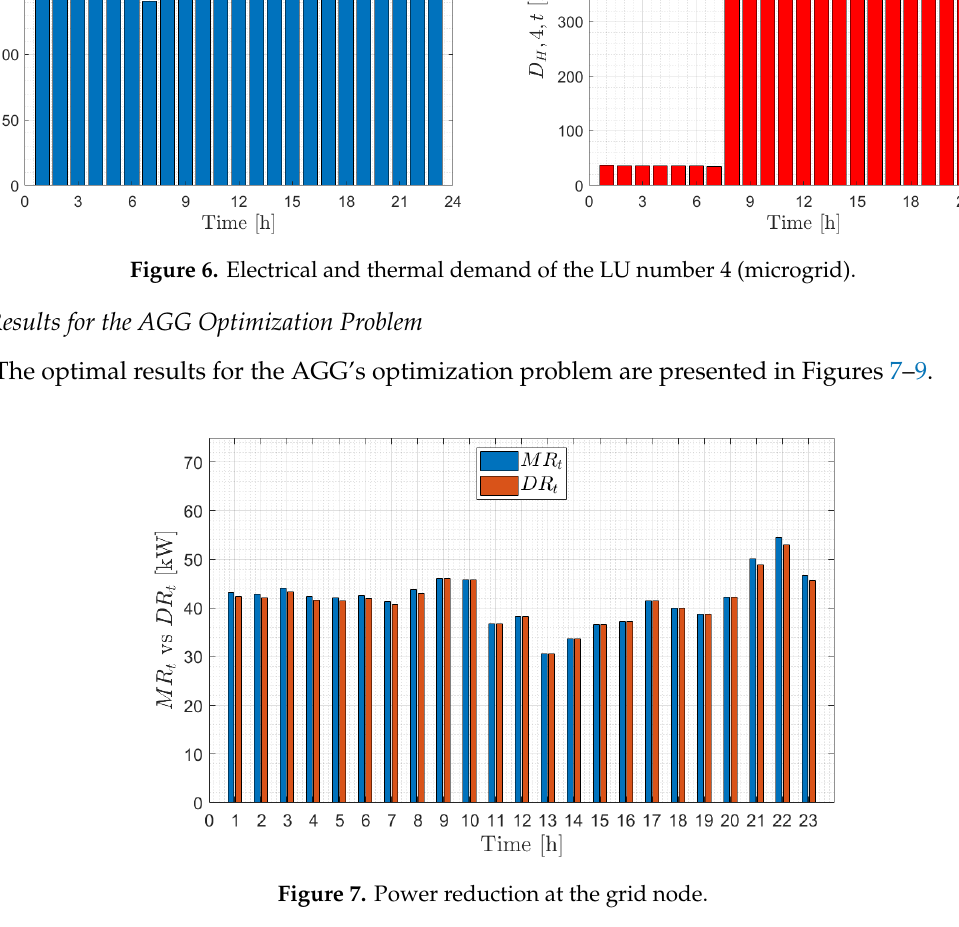
Figure 7. Power reduction at the grid node.